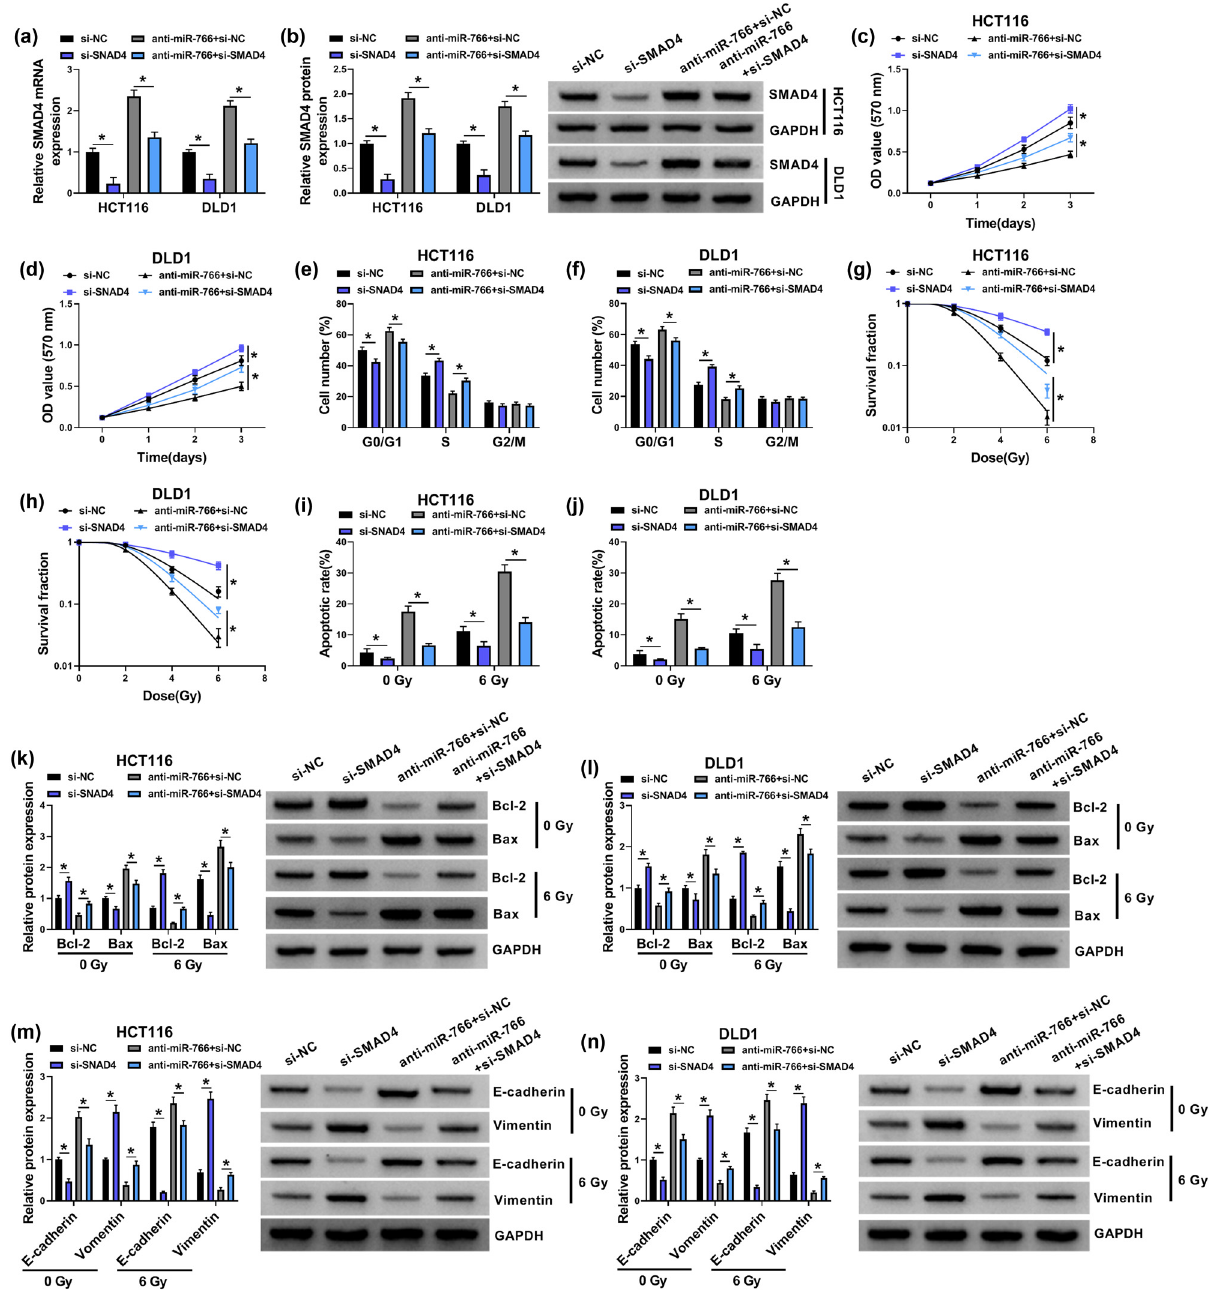
Figure 6: Inhibition of miR - 766 suppresses cell growth and enhances radiosensitivity in CRC via SMAD4. ( a – l ) HCT116 and DLD1 cells were co - transfected with anti - miR - NC, anti - miR - 766, anti - miR - 766 + si - NC, or anti - miR - 766 + si - SMAD4. ( a and b ) qRT - PCR and western blot analysis of SMAD4 expression in HCT116 and DLD1 cells. ( c and d ) CCK - 8 assay for the proliferation of HCT116 and DLD1 cells. ( e and f ) Flow cytometry for cell cycle distribution in HCT116 and DLD1 cells. ( g and h ) Colony formation assay for survival fraction in transfected HCT116 and DLD1 cells exposed to various doses of irradiation ( 0, 2, 4, or 6 Gy ) . ( i and j ) Flow cytometry for the apoptosis of transfected HCT116 and DLD1 cells exposed to 0 or 6 Gy irradiation. ( k – n ) Western blot analysis of Bax, Bcl - 2, E - cadherin, and Vimentin protein levels in transfected HCT116 and DLD1 cells exposed to 0 or 6 Gy irradiation. * P <